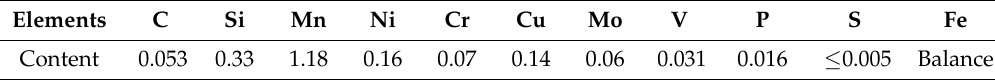
Table 2. Chemical compositions of X65 steel (wt.